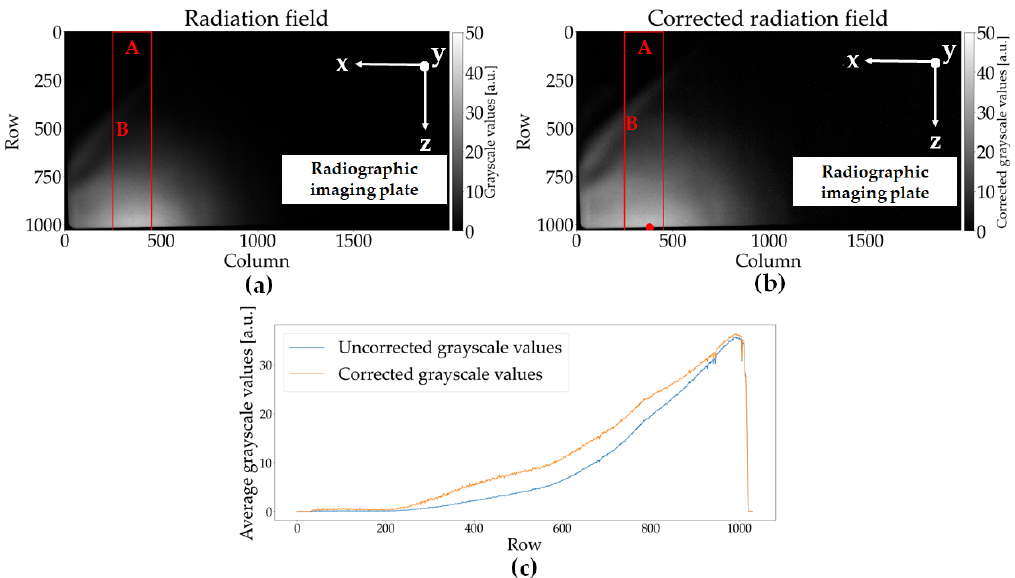
Figure 5. ( a ) Uncorrected and ( b ) distance-corrected grayscale image captured with the radiographic imaging plate. Both images show that a large part of the X-ray radiation is emitted very flat and almost exclusively parallel to the sample plate in the y -direction. The edge of the imaging plate can be seen very well as a sudden drop in the grayscale values in the lower and left part of the image. The red rectangles in ( a , b ) show the area of the pixels used for the profile curve plotted in ( c ). The red dot in ( b ) marks the position of the shortest distance to the plasma used for the calculation of the distance correction. ( c ) Cross-section of the grayscale values along the rows of the corrected (orange curve) and uncorrected (blue curve) grayscale images. The continuous decrease in grayscale value with a decreasing row number in the profiles indicates that a large part of the laser-induced X-rays is emitted in a very flat angle close to the horizontal plane.